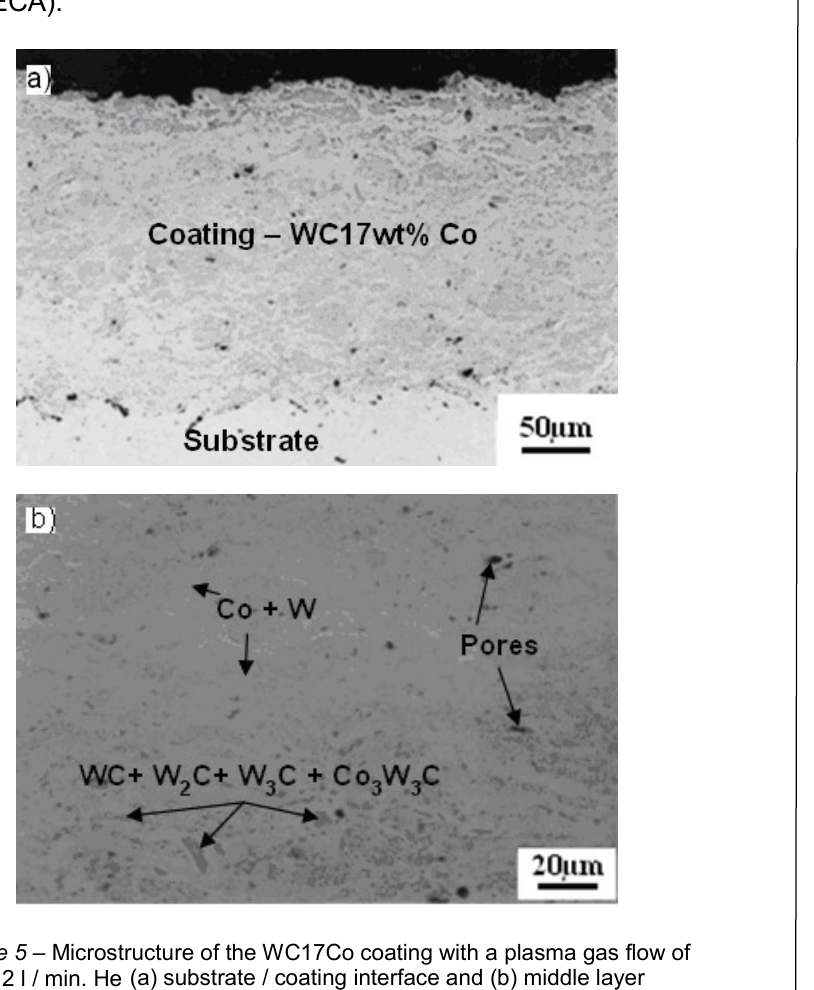
Figure 5 – Microstructure of the WC17Co coating with a plasma gas flow of 12 l / min. He (a) substrate / coating interface and (b) middle layer Slika 5 – Mikrostruktura prevlake WC17Co sa protokom plazma gasa 12 l/minHe, (a) interfejs substrat/prevlaka i (b)sredina prevlake The measured values of the total content of pores in the WC17Co layers are consistent with the measured microhardness